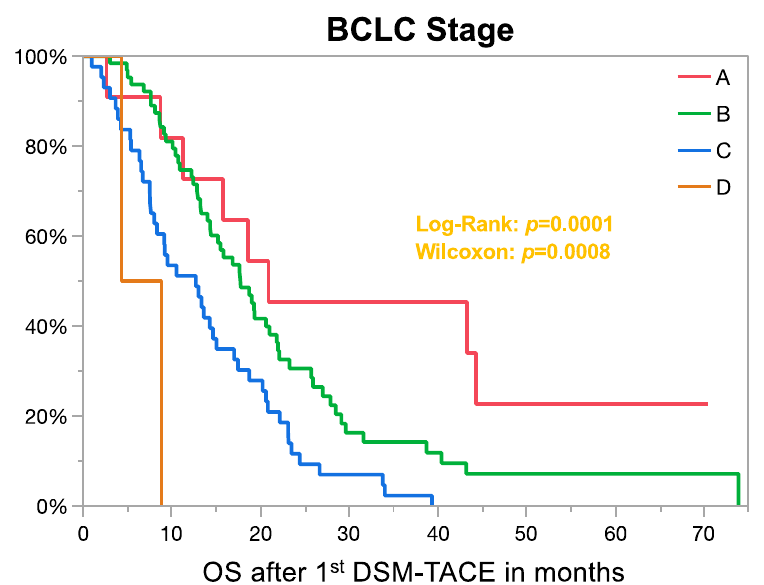
Figure 1. Overall survival (OS) following first DSM-TACE. OS of all patients ( A ) and stratified by institution ( B ) following first DSM-TACE. There were no statistically significant differences between institutions.